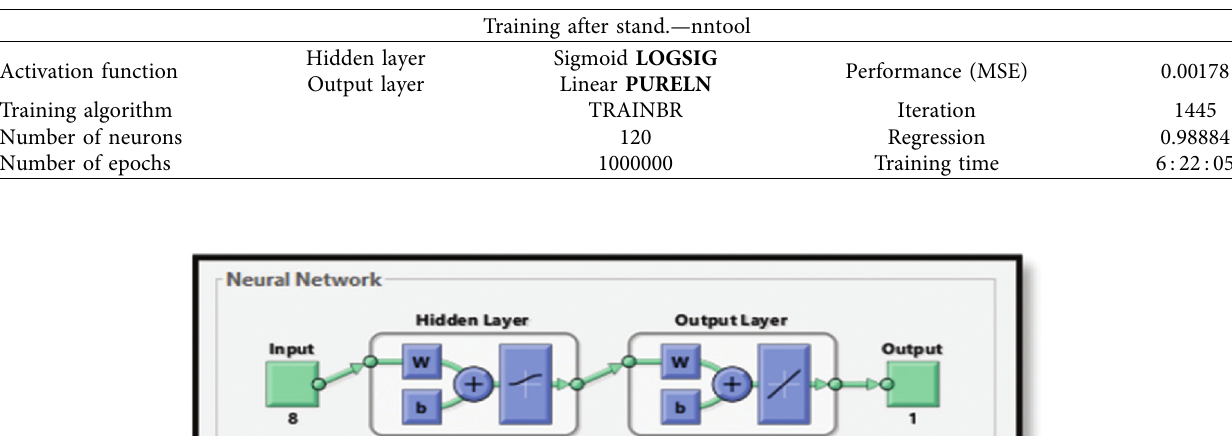
Table 9: Results from training datasets using MATLAB based on the methods of data